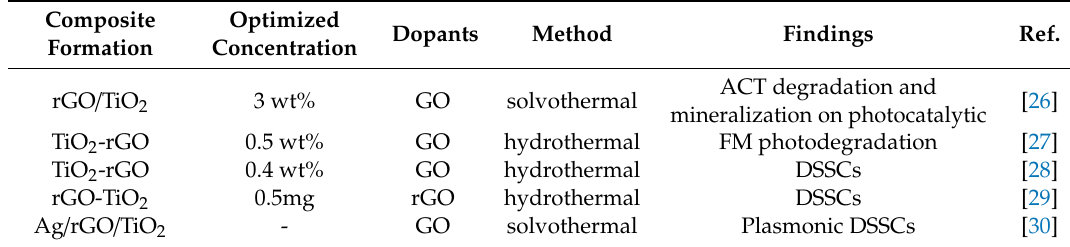
Table 1. Summary of rGO-TiO 2 nanocomposites by di ff erent